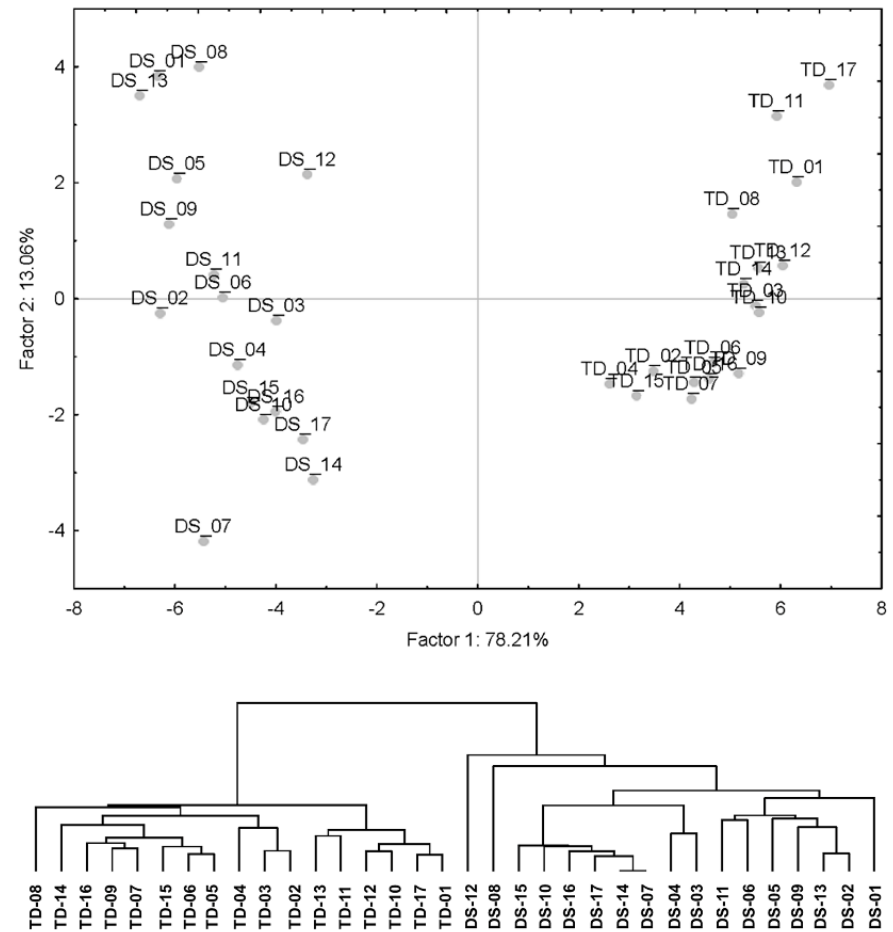
Figure 1. Clustering analysis of children with and without DS based on the methylation levels of 4806 DMPs: PCA plot based on the correlation matrix ( top ), and a hierarchical tree constructed using the Manhattan distances and the Ward clustering algorithm ( bottom ). The plots show that the toddlers with and without DS are grouped into separate remote clusters based on the DMP methylation profiles.